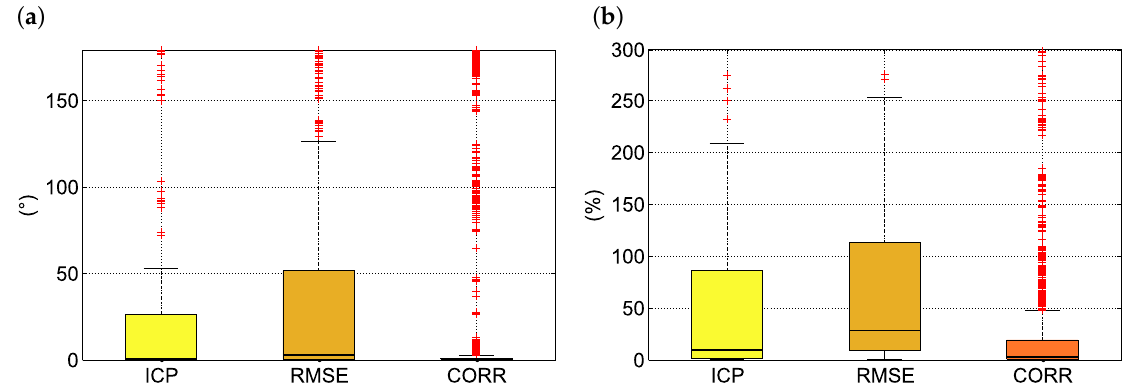
Figure 7. A boxplot visualization of the absolute ( a ) and the relative ( b ) rotation error of all scan matching experiments (section Total of Table